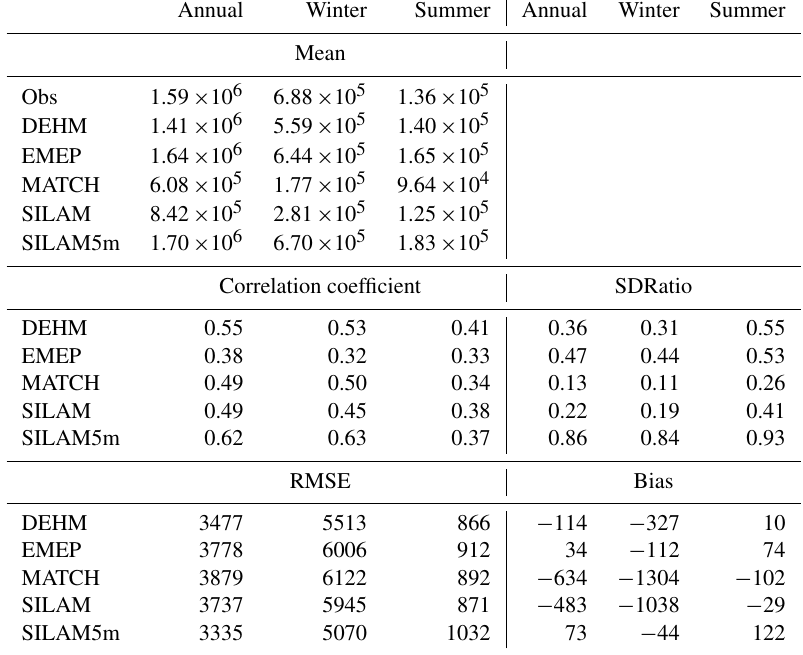
Table 4. Statistical evaluation of model results for SSA wet deposition, considering the accumulated deposition over the whole year (mgNa + m − 2 yr − 1 ), winter (December, January, and February), and summer periods (June, July, and August) (mgNa + m − 2 period − 1 ), for 133 EMEP measurement sites, between 1990 and 2009. SILAM5m is the evaluation if considering the whole possible size range for SSA D p =